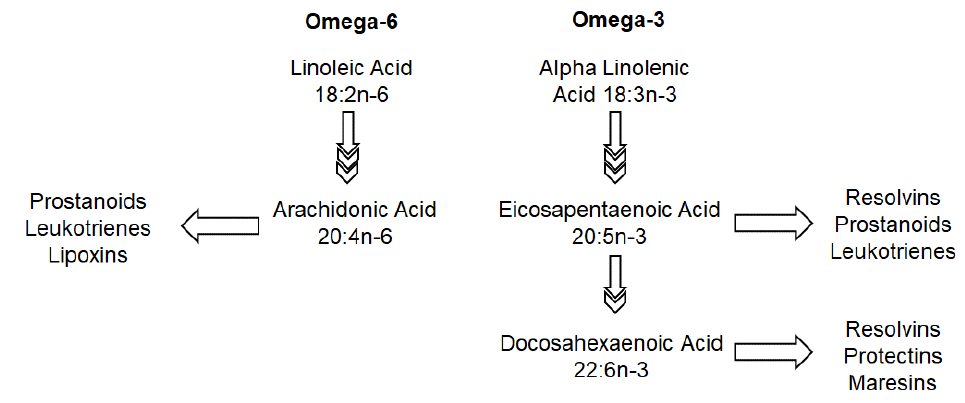
Figure 1. Omega-6 and Omega-3 fatty acid metabolism.